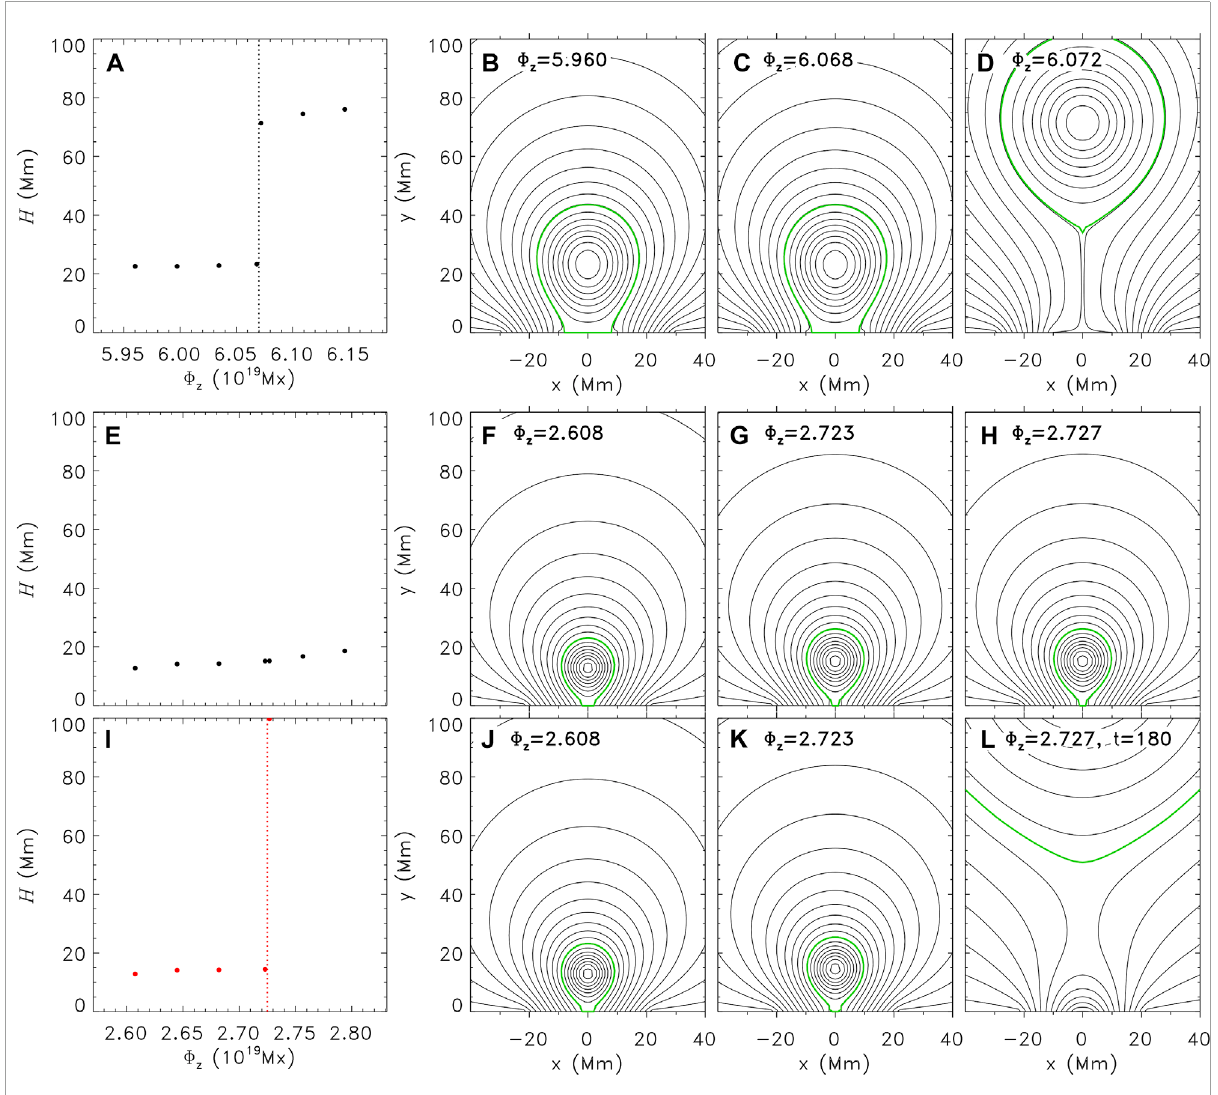
FIGURE 4 The simulation results for Case III and Case IV. Panel (A–D) are the simulation results for Case III under the ideal MHD condition. Panels (E–H) and panels (I–L) are the simulation results for Case IV under the ideal MHD condition and the resistive condition, respectively; the red vertical dotted line in panel (I) denote the catastrophic point Φ c zc . The green curves mark the boundary of the flux rope.